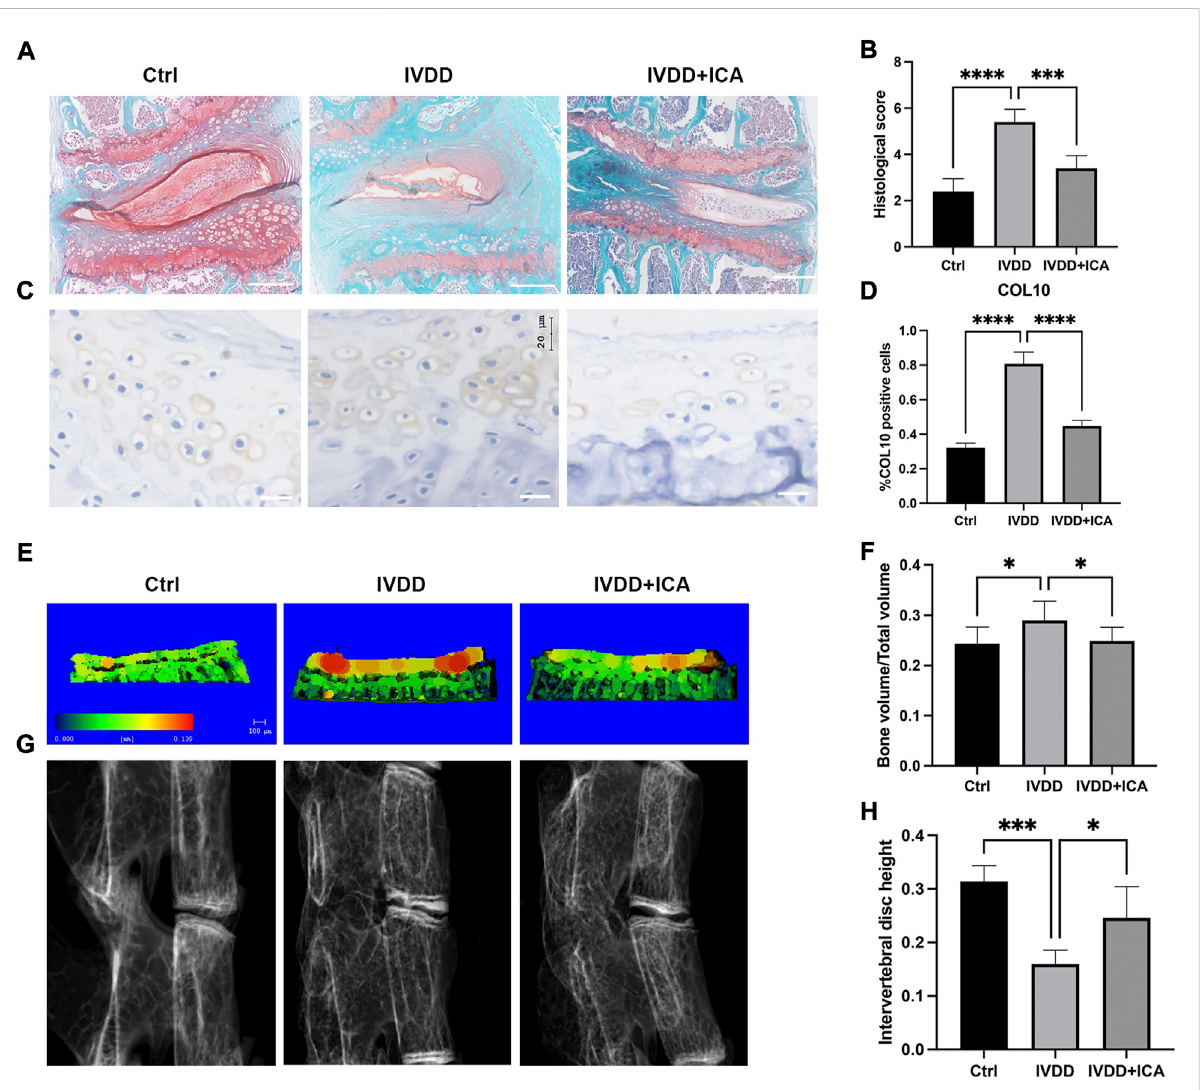
FIGURE 1 ICAalleviatedcartilageendplate degeneration and IVDDprogression invivo . (A) SafraninO/fastgreenstainingofL4/5intervertebral discsinthe Ctrl,IVDD,andIVDD+ICAgroups.Scalebar=200 μ m. (B) HistologicalscoreoftheL4 – 5segmentsofthelumbarspineamongthethreegroups. (C) Immunohistochemical staining of COL10 in endplate chondrocytes from each group. Scale bar = 20 μ m. (D) Ratio of positive cells for COL10 was quanti fi ed under a microscope at ×400 magni fi cation using fi ve sections from fi ve mice. (E) Micro-CT analysis of cartilage endplate. Red staining of cartilage endplate means elevated bone mineral density. Scale bar = 100 μ m. (F) Quanti fi cation of cartilage endplate calci fi cation via microarchitecture parameters [bonevolume pertissue volume (BV/TV)]. (G – H) X-ray images ofL4/5 segments of lumbarspine among three groups andhistomorphometricassessmentofintervertebraldischeight.Theintervertebraldischeightwascalculatedbytheaverageoftheanterior,middle, and posterior of intervertebral disc. Data are presented as mean ± SD. * p < 0.05, ** p < 0.01, *** p < 0.001, and **** p <